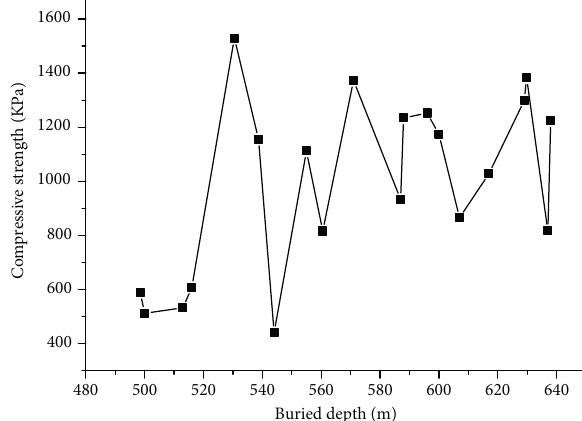
Figure 5: Curve of compressive strength and depth of deep clay in